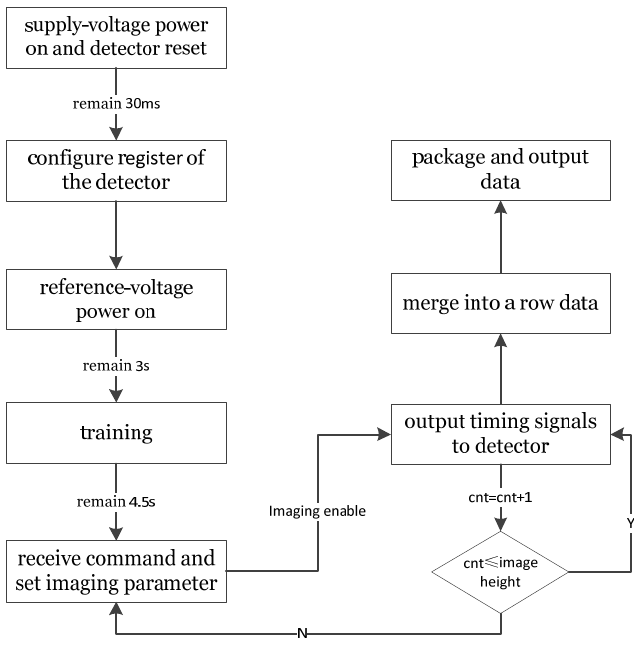
Figure 9. The system workflow diagram.